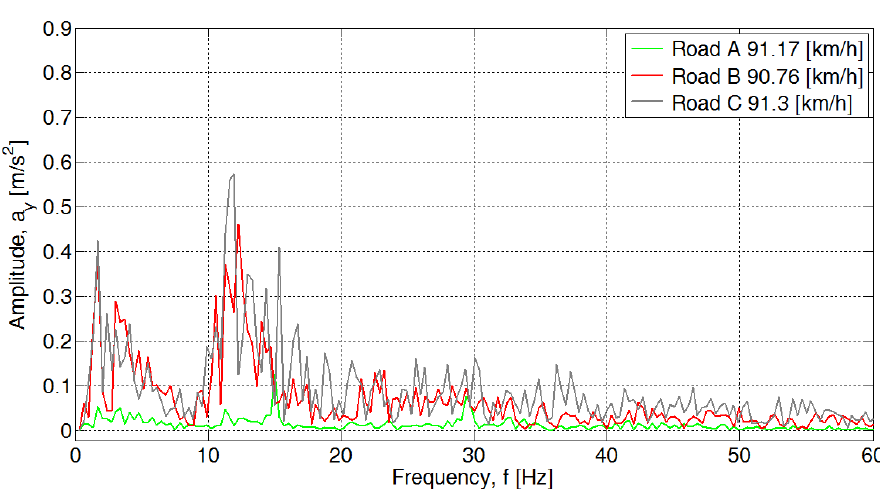
Figure 10. Amplitude of the body accelerations in the transverse direction for a selected random window for a given speed (y axis), for test surface conditions A, B and C.